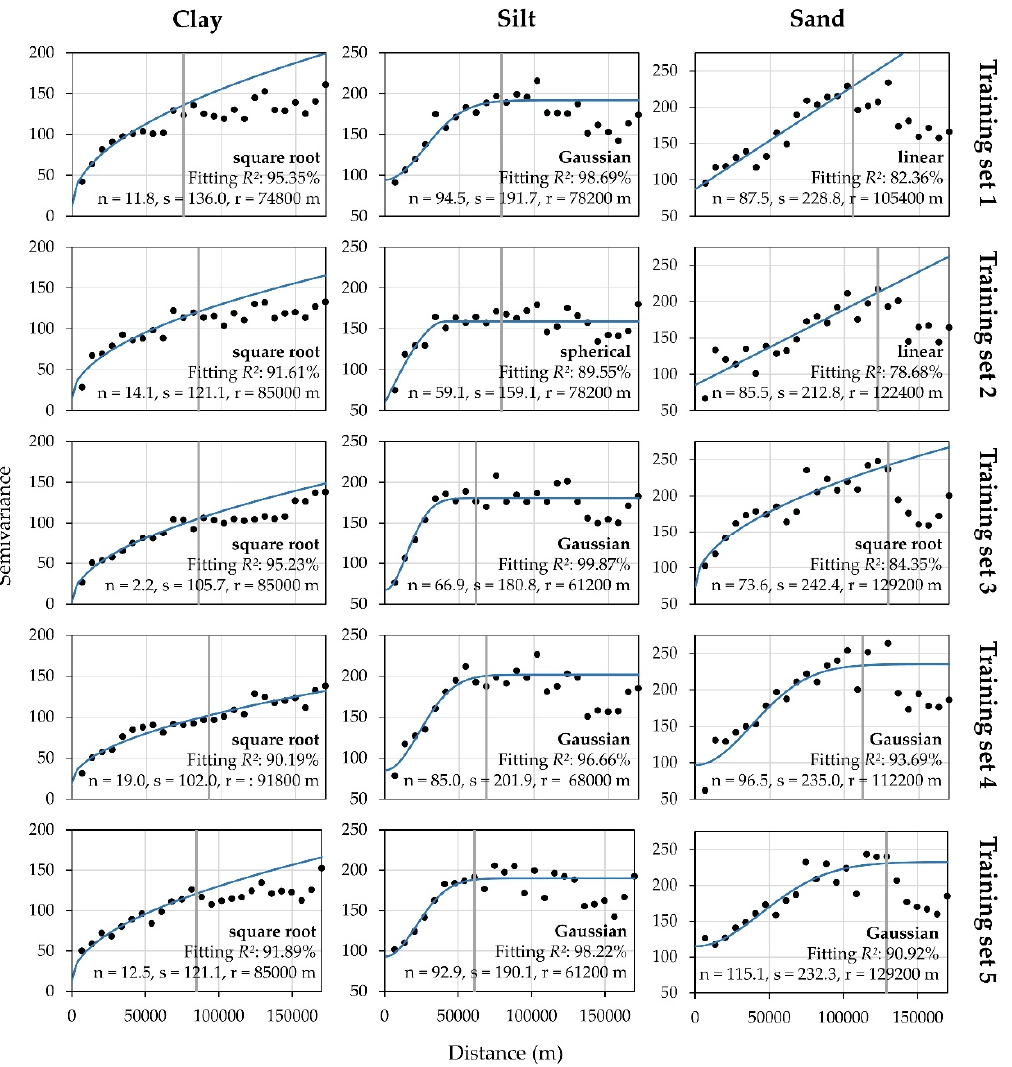
Figure A2. Variograms and OK interpolation parameters of five training sample sets (n: nugget, s: sill, r: range).